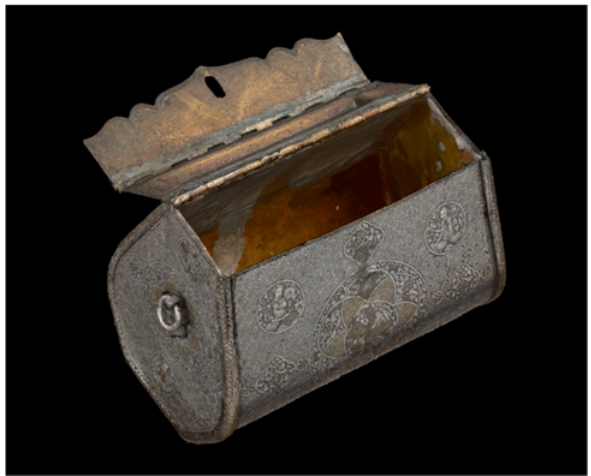
Figure 5. Rendered 3D model of the handbag, showing both exterior and interior